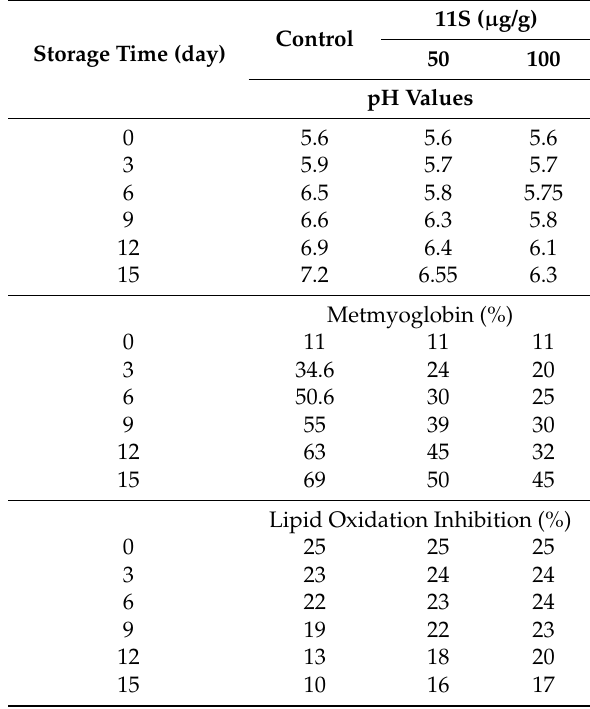
Table 3. Physicochemical analysis of meat